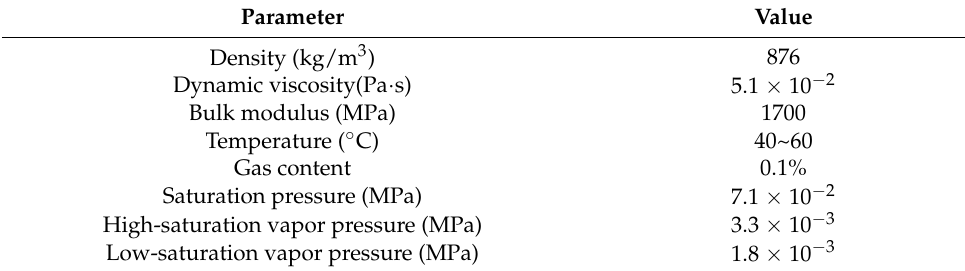
Table 2. Properties of hydraulic